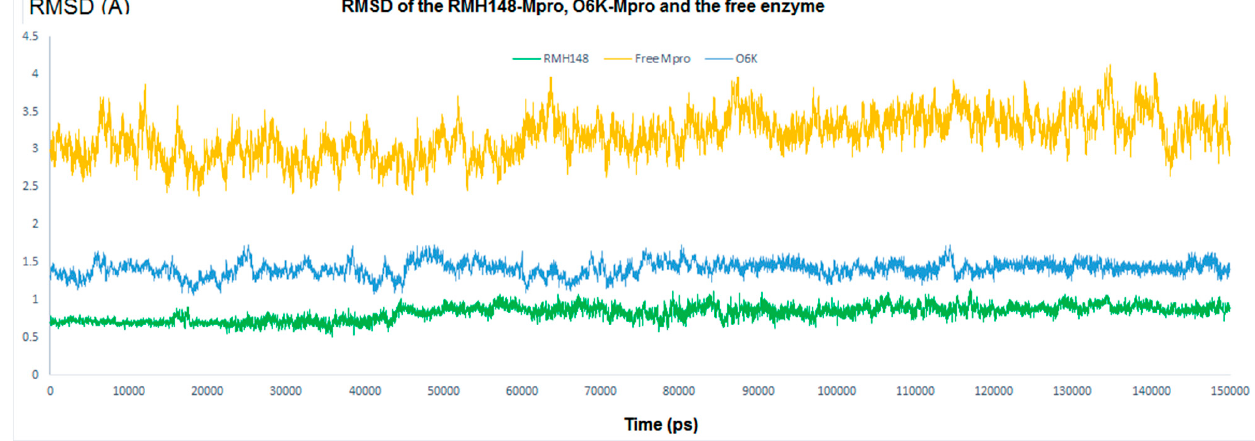
Figure 4. The 3D ( A ) and 2D ( B ) interaction diagram between RMH148 and the Mpro enzyme; the ligand is shown in stick presentation. Relevant residues at the active site are shown in line presentations. Bond lengths between the ligand and interacting residues are shown in the 3D diagram.